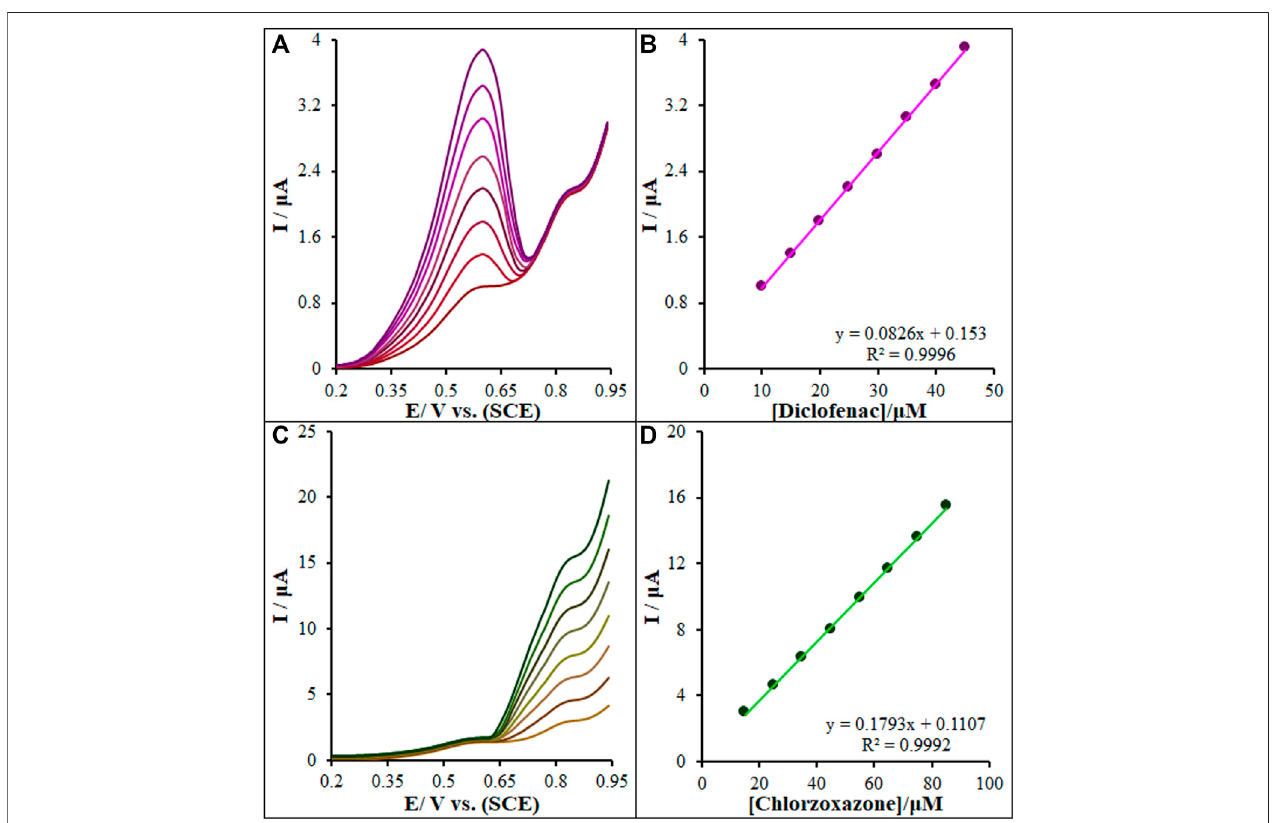
FIGURE13|(A) DPVs ofLa 2 O 3 @SF-LCu 2 S/GCE in0.1 M(pH 7.0) containing 15.0 µM ofchlorzoxazone, and different concentrationsofdiclofenac (from inner to outer curve): 10.0, 15.0, 20.0, 25.0, 30.0, 35.0, 40.0, and 45.0 µM. (B) Analytical curve from diclofenac. (C) 15.0 µM of diclofenac, and different concentrations of chlorzoxazone (from inner to outer curve): 15.0, 25.0, 35.0, 45.0, 55.0, 65.0, 75.0, and 85.0 µM. (D) Analytical curve from